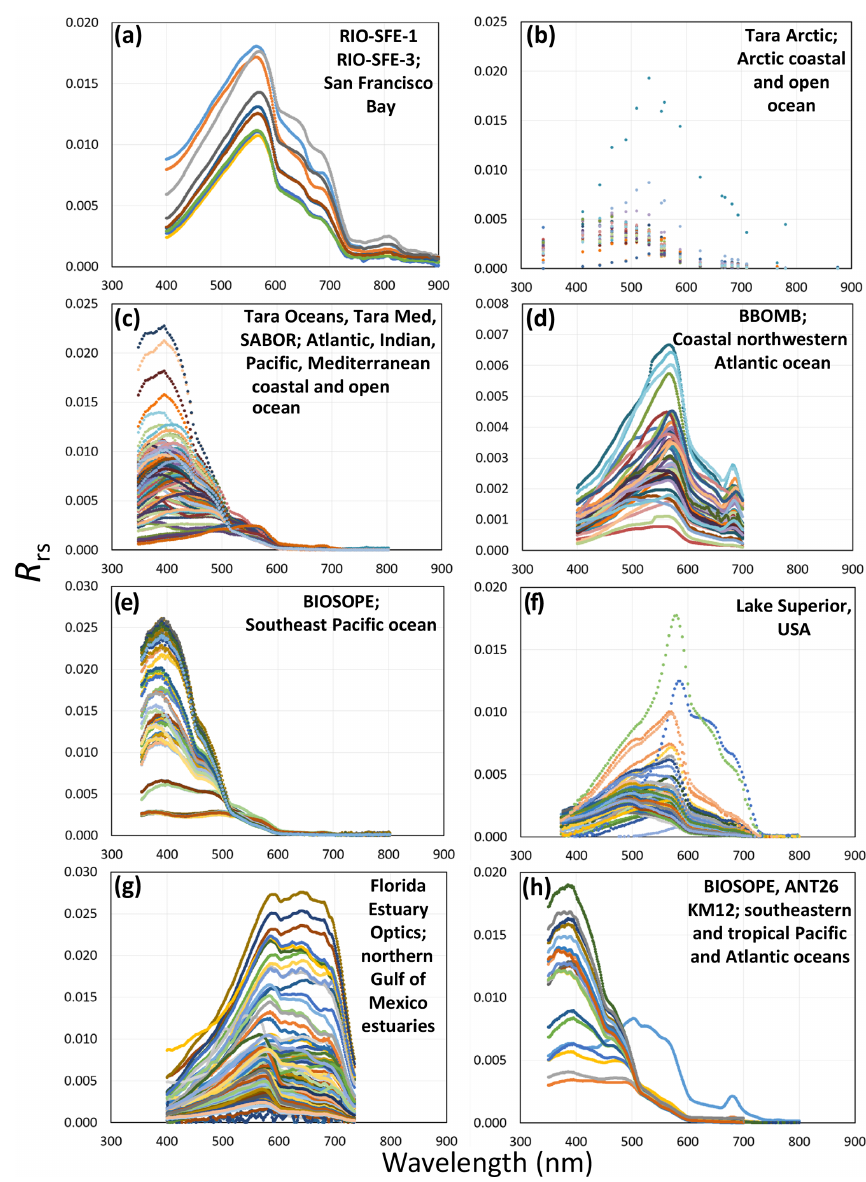
Figure 4. Plots demonstrating the spectral reflectance diversity of inland, estuary, and ocean environments (location information is provided in Fig. 3). Reflectance distribution plots display R rs data from (a) San Francisco Bay waters (Ackleson); (b) Arctic coastal and open-ocean waters (Boss and Chase Arctic); (c) Atlantic Ocean, Indian Ocean, Pacific Ocean, and Mediterranean Sea coastal and open-ocean waters (Boss and Chase); (d) coastal northwestern Atlantic ocean waters (Craig); (e) southeastern Pacific ocean waters (Lewis); (f) Lake Superior, USA, inland water (Mouw); (g) northern Gulf of Mexico estuaries (Schaeffer); and (h) southeastern and tropical Pacific and Atlantic ocean waters (Stramski and Reynolds). Note that subplots demonstrate the spectral sampling interval provided; where high spectral